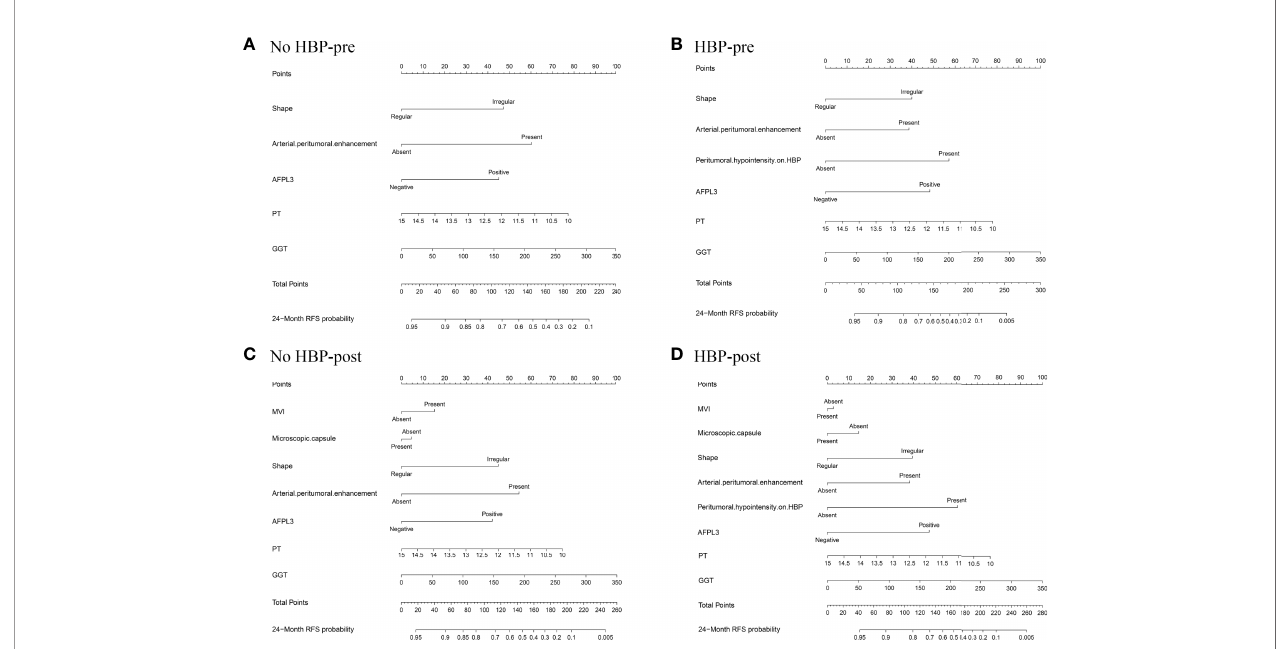
FIGURE 3 | Nomograms predicting probability of early recurrence: (A) No HBP-pre model, the preoperative model without HBP imaging feature; (B) HBP-pre model, the preoperative model with HBP imaging feature; (C) No HBP-post model, the postoperative model without HBP imaging feature; (D) HBP-post model, the postoperative model with HBP imaging